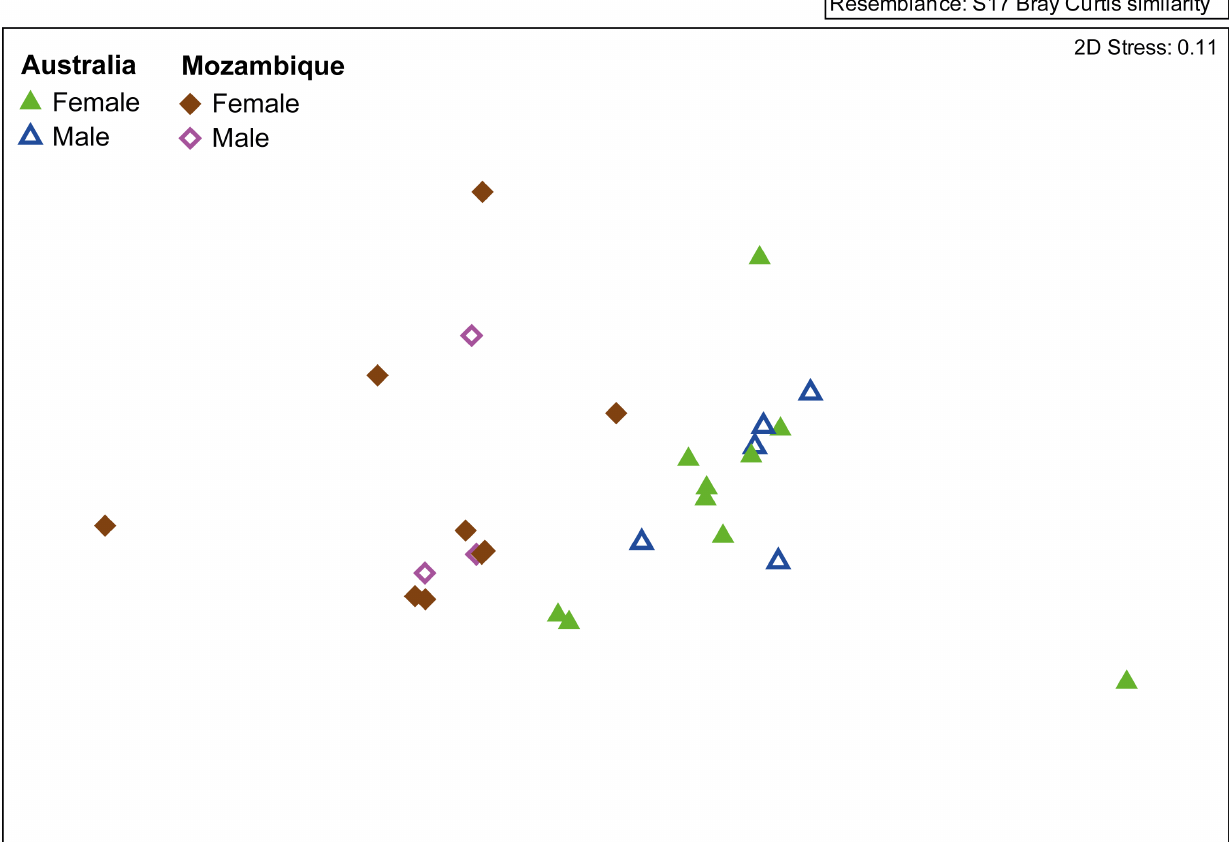
Figure 2. Regional comparison of reef manta ray muscle tissue fatty acid (FA) profiles. Multi-dimensional scaling ordinations of different sexes considering all FA . 0.2% (n=39).